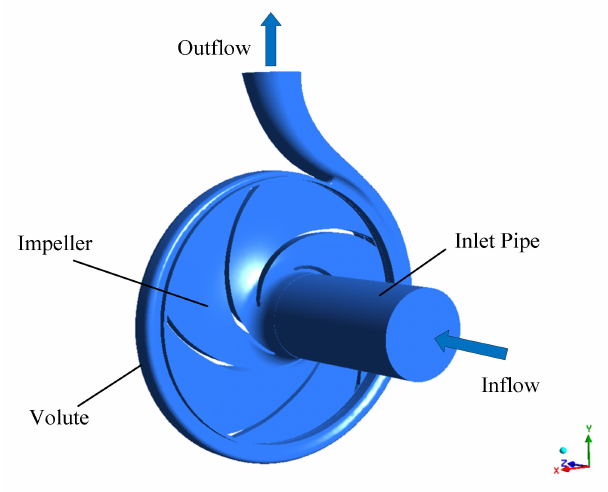
Figure 1. The inlet pipe, the impeller and the volute of the centrifugal